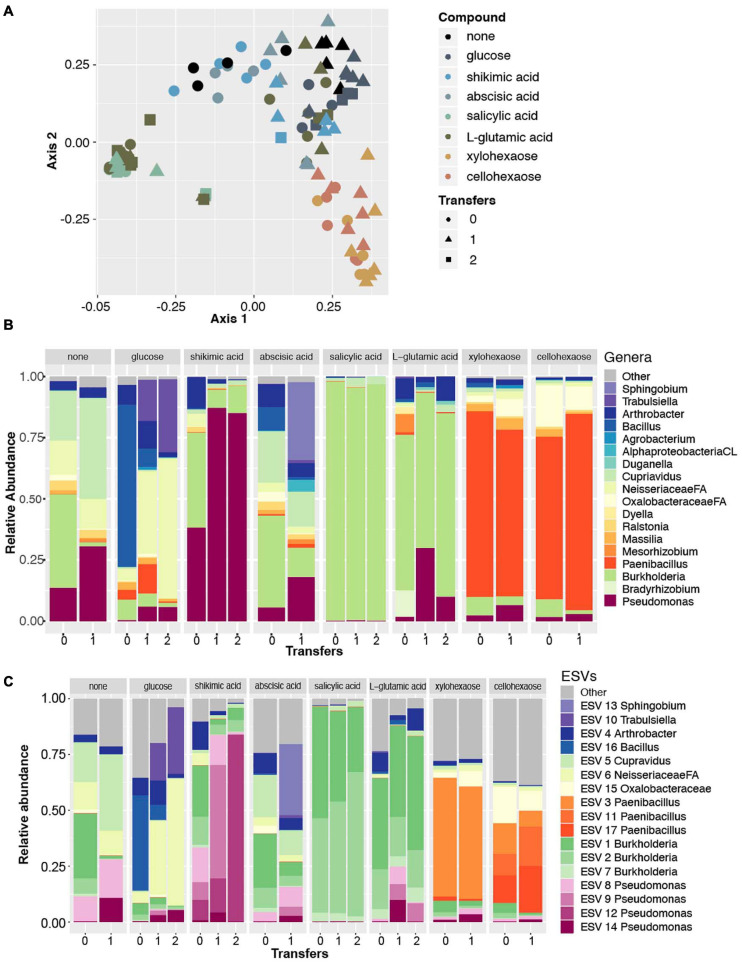
Amplicon data reveals Pseudomonas enriched in minimal media with shikimic acid. (A) Principal coordinate analysis of all amplicon data across eight enrichment treatments (as indicated by color) and three different numbers of experimental transfers (as indicated by shape). (B) Relative abundance of the top eighteen most abundant genera across the dataset for each enrichment compound (facets) and for each distinct number of transfers/subcultures (x-axis). Colors for three genera that were also identified as abundant in previous experiments (Pseudomonas, Bradyrhizobium, Burkholderia) are plotted with the same colors as previously; the remaining genera are plotted with new colors. (C) Relative abundance plots of individual ESVs within this dataset. Individual ESVs are colored with the same colors used to plot their respective genera in the previous panel. In three cases where multiple ESVs mapped to an individual genus (Pseudomonas, Burkholderia, and Paenibacillus), shades of the previously used color are used to indicate distinct ESVs.